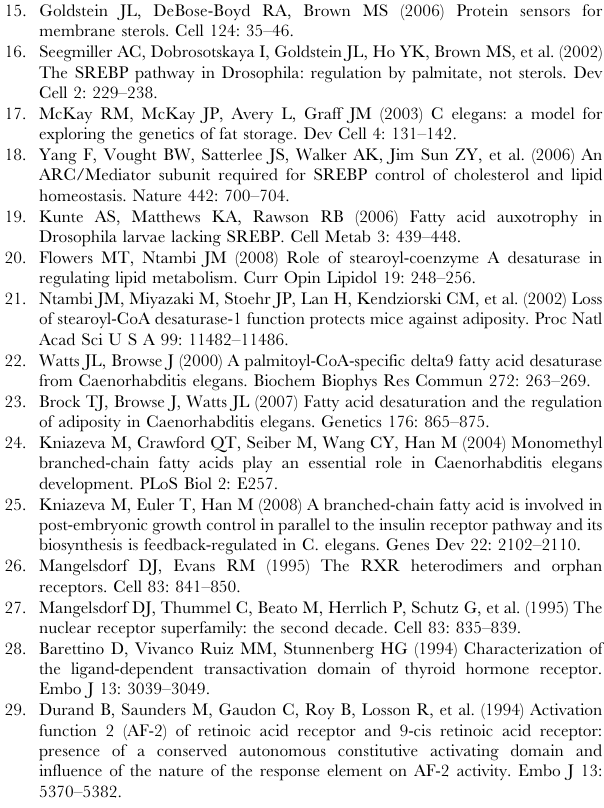
E. coli strain OP50. (A) The nhr-64(ok1957) mutant strain contains increased levels of C15iso and C17iso and decreased C18:0 compared to wild type. (B) The fat-6;fat-7;nhr-64(ok1957) triple mutant strain contains increased levels of C15iso and C17iso and